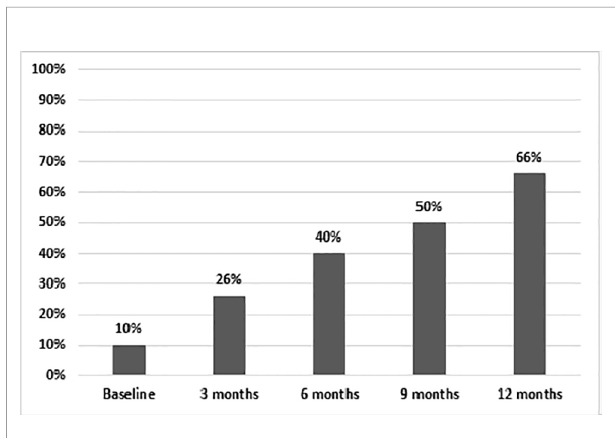
FIGURE 3 | Proportion of patients with <80 PANSS total score.